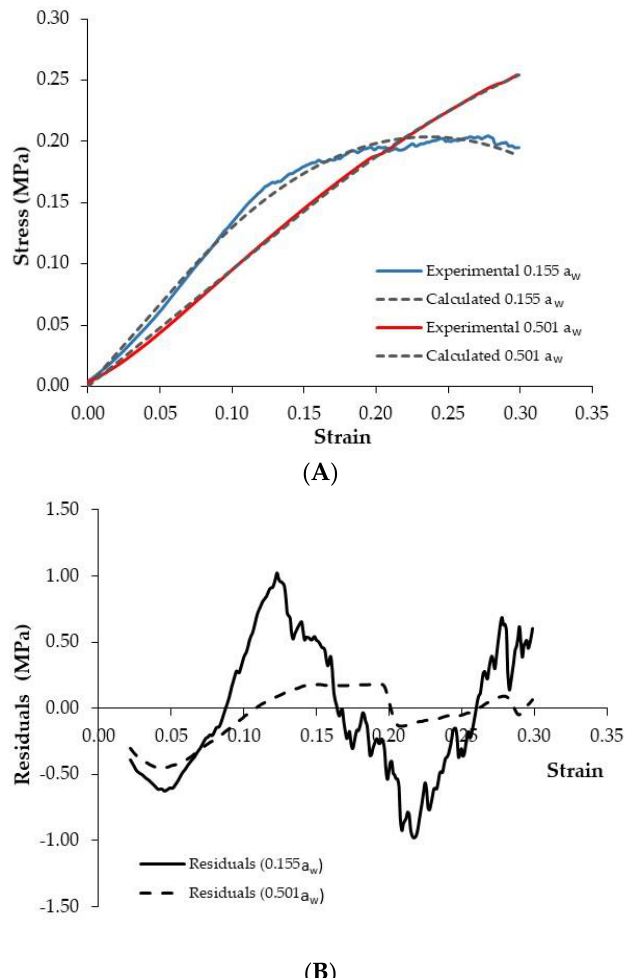
Figure 7. Experimental and calculated stress – strain profile of puffed corn cakes (PCC) ( n = 30) stored at 0.155 and 0.501 water activity ( A ) and distribution of residuals ( B ).